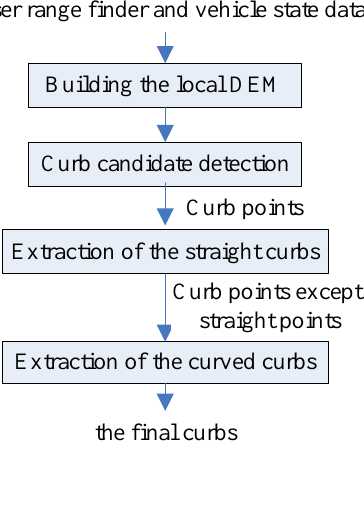
Figure 1. Flowchart of the new curb detection